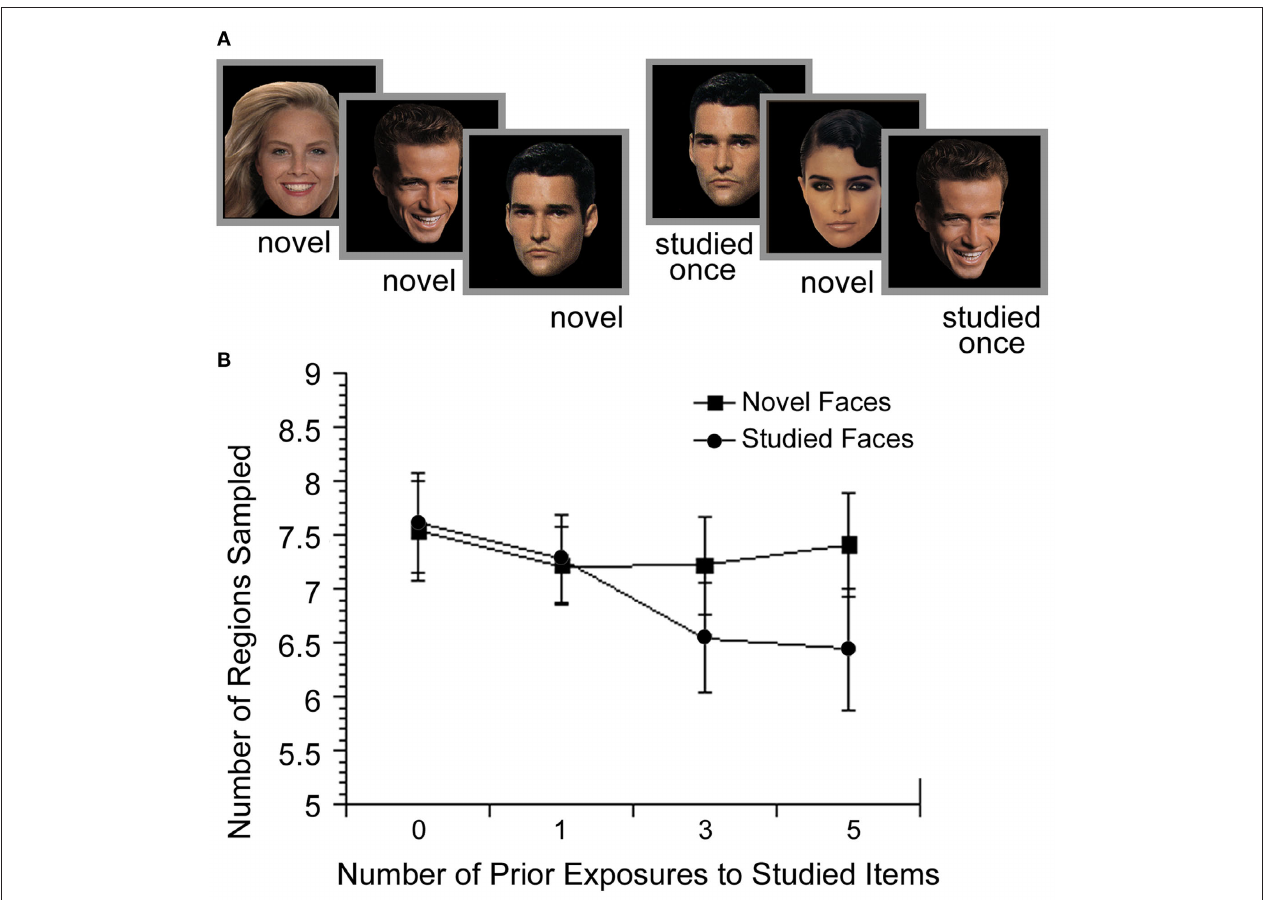
the studied faces, compared to novel (non-studied) faces that were introduced during the same phase of the experiment. These findings illustrate the influence of memory for the previously viewed faces on subsequent